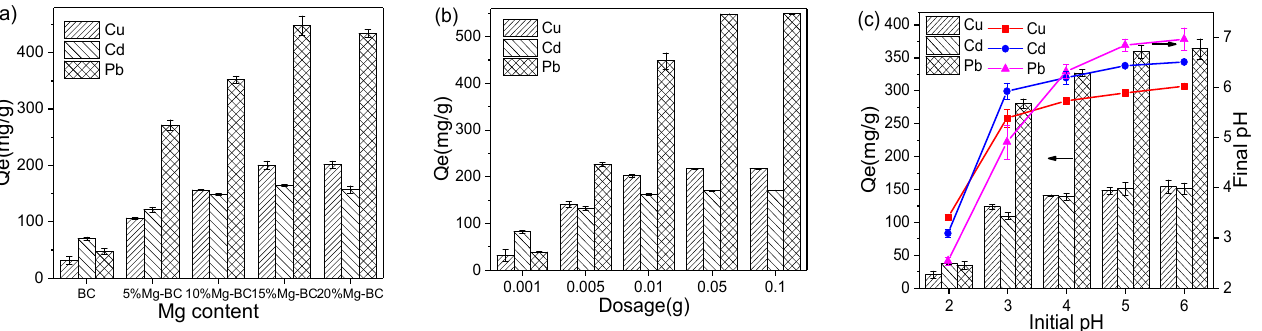
Figure 3. The impact of Mg content ( a ), dosage ( b ), and initial pH ( c ) on the sorption of heavy metals by biochars.